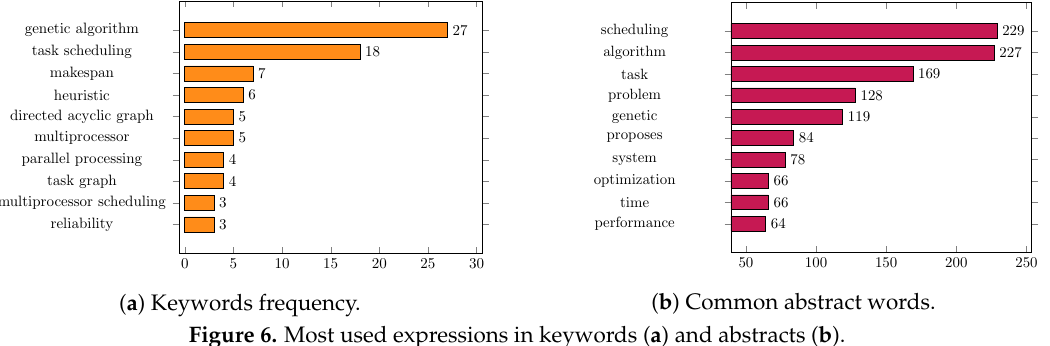
Figure 6. Most used expressions in keywords ( a ) and abstracts ( b